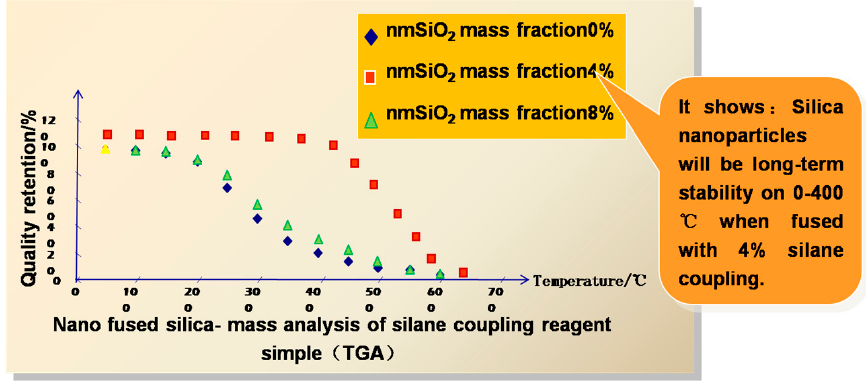
Figure 18. Testing result of the glue, the sample with the particles of 4% nanometer SiO 2 is the optimized one.